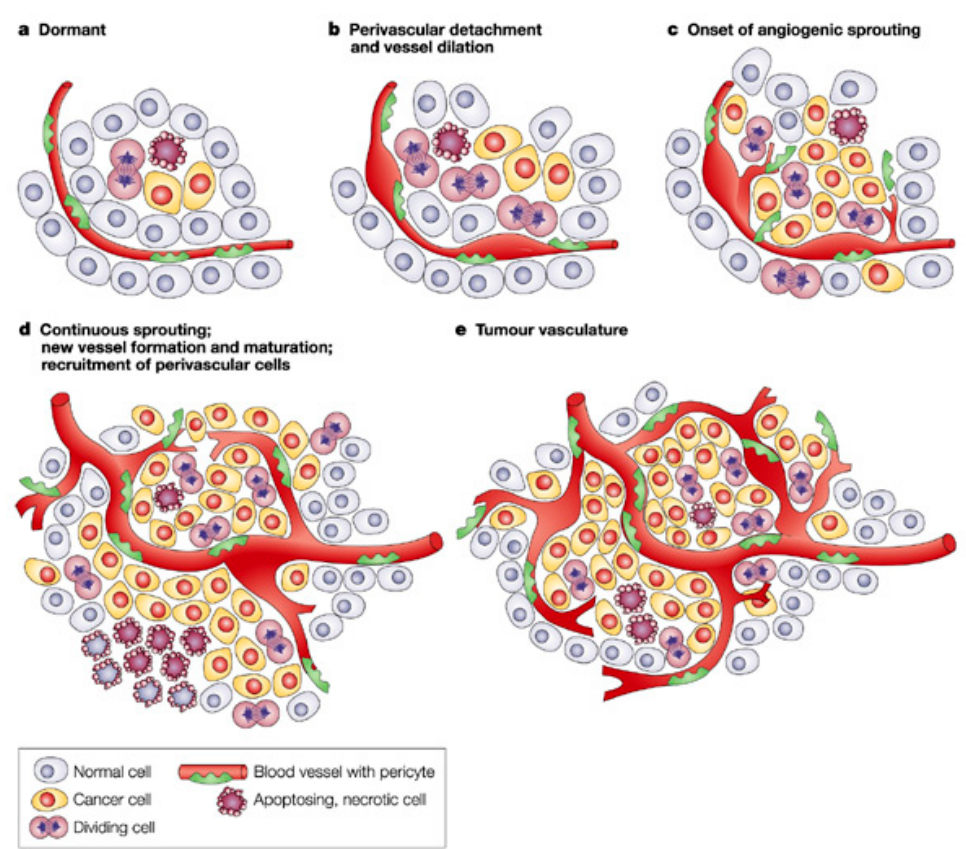
Figure 1. ( a – e ) Angiogenic “switch” from dormant cells to tumor vasculature. Adapted from Bergers, G. Benjamin, L.E. Nat. Rev. Cancer 2003 , 3 , 401. Copyright 2003 Nature Publishing